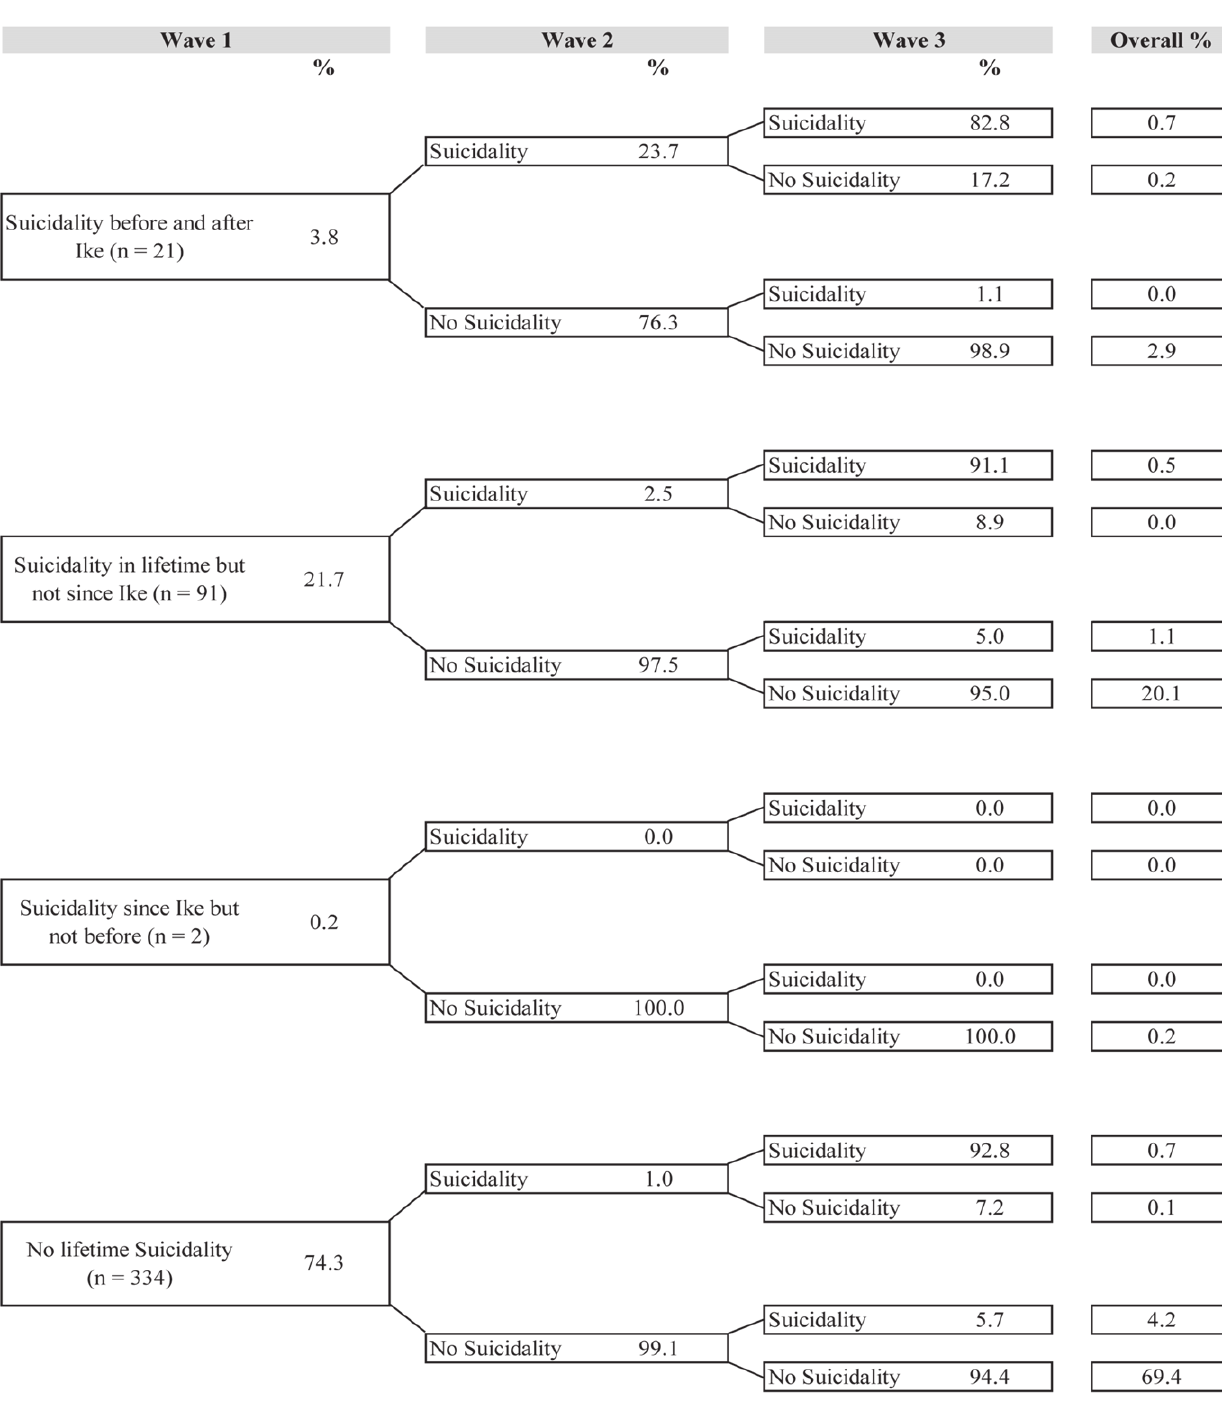
population [2]. The past-month prevalence of panic disorder of 0.8% at Wave 1 was lower than the 9.3% prevalence documented in a study of Vietnamese adults affected by a typhoon [10]. The past 14 to 18-month prevalence of panic disorder (2.2%) in the current sample was comparable to the 2.7% past 12-month prevalence of this disorder in the general U.S. adult population [2]. The past-month prevalence of depression of 5.0% at Wave 1 is